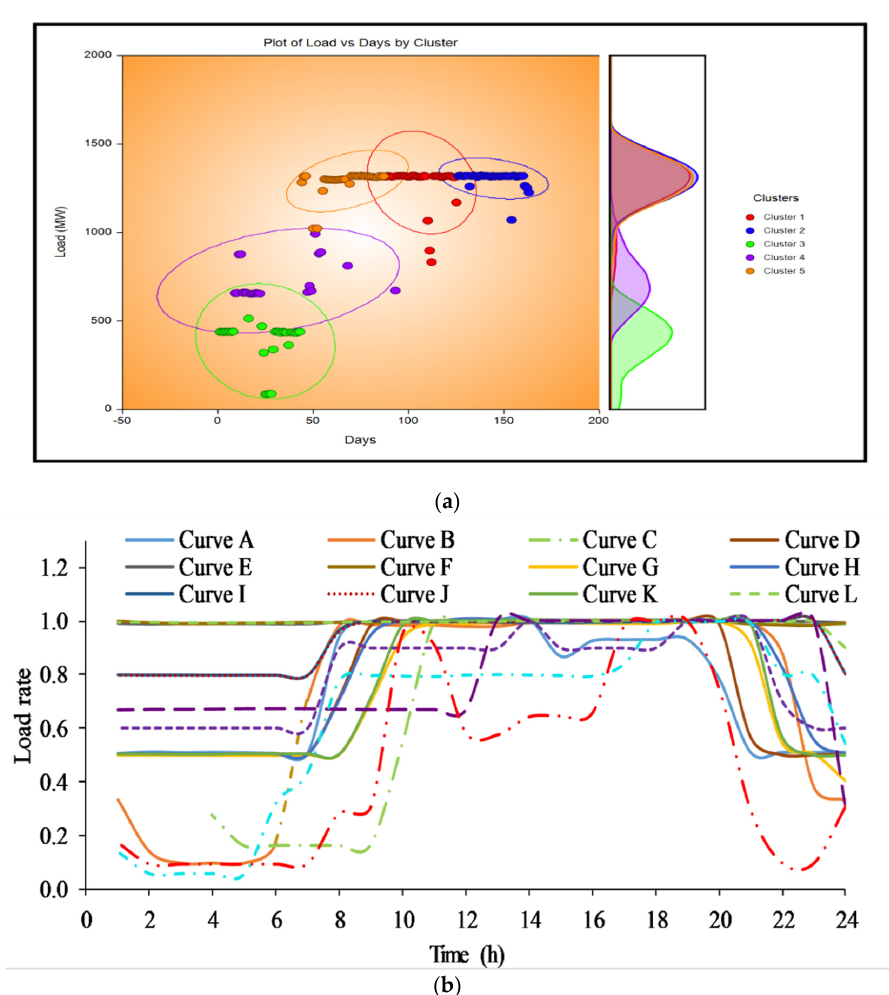
Figure 4. Tianshengqiao plant 2: ( a ) cluster analysis; ( b ) typical generation curves.